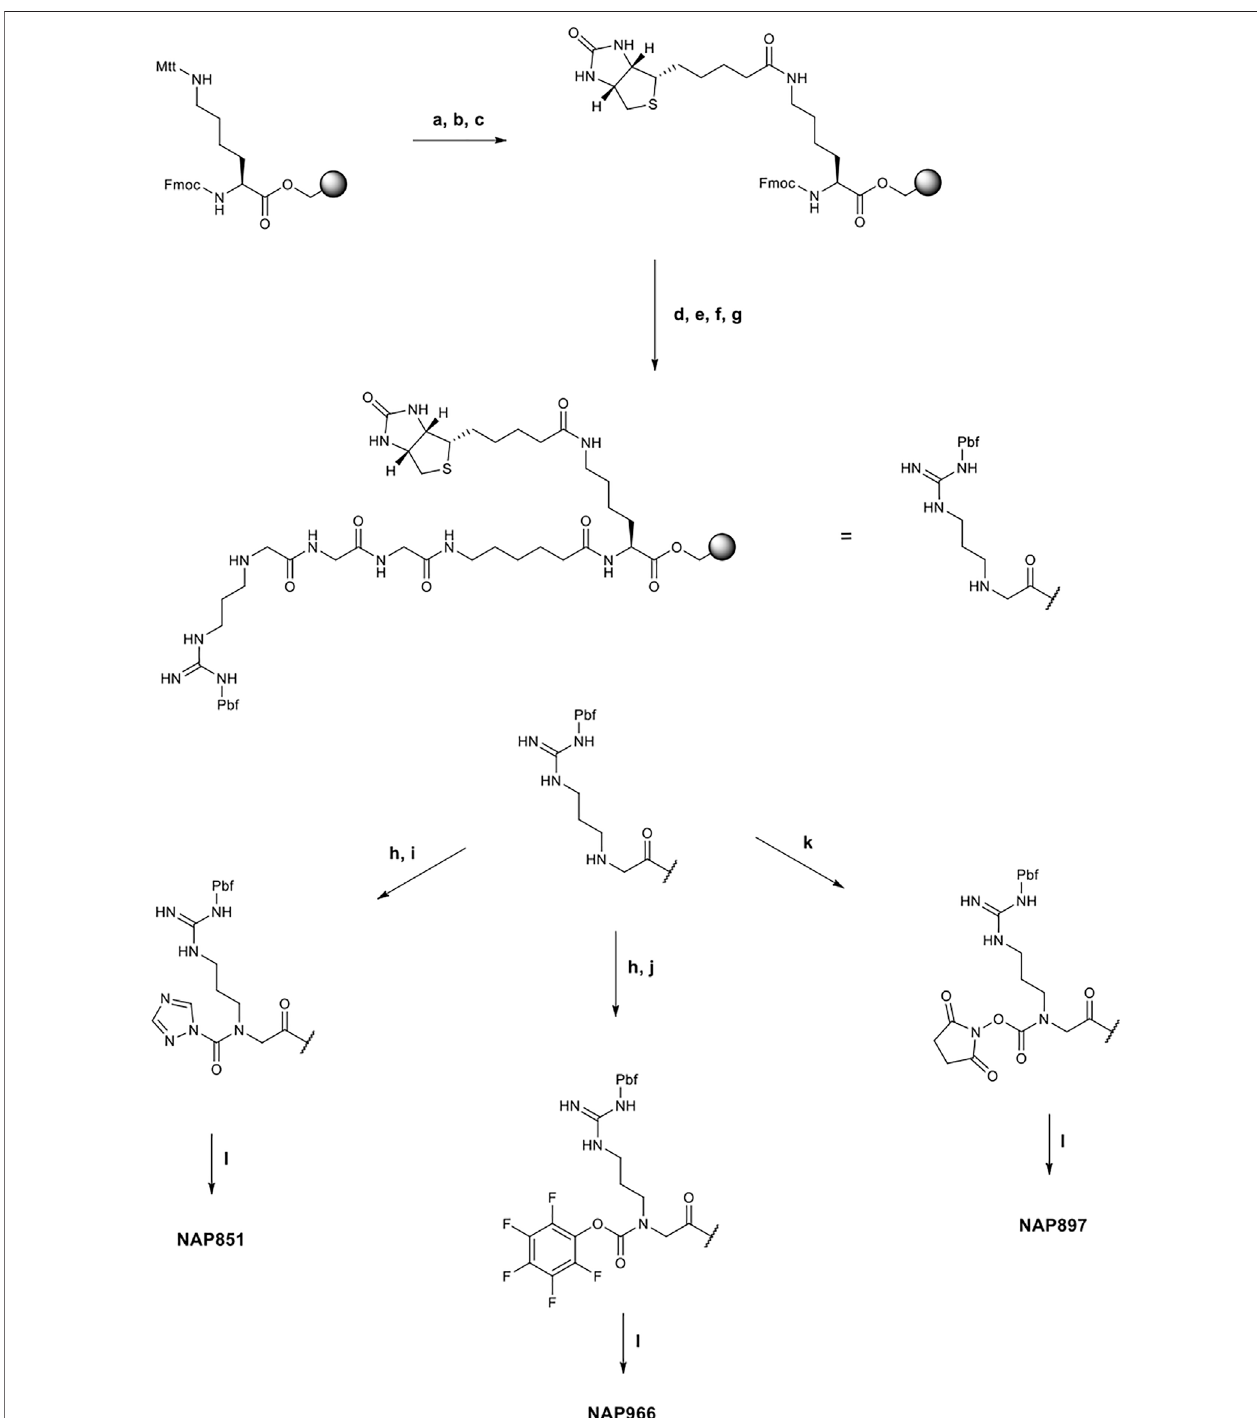
FIGURE 1 | Synthetic schemes for the preparation of NAP851, NAP966 and NAP897. (A) TFA/TIPS/DCM (5/5/90, v/v/v), (B) DIPEA/DMF (1/99 v/v), (C) Biotin, DIC, HOBt, NMP, (D) i) Piperidine/DMF (1/5, v/v), ii) Fmoc-Ahx-OH, DIC, HOBt, DMF, (E) i) Piperidine/DMF (1/5, v/v), ii) Fmoc-Gly-OH, DIC, HOBt, DMF, then repeat i) and ii) for a second Gly residue, (F) i) Piperidine/DMF (1/5, v/v), ii) Fmoc-NArg (Pbf)-OH, DIC, HOBt, DMF, (G) Piperidine/DMF (1/5, v/v), (H) Triphosgene, 2,6-lutidine, anhydrous DCM, (I) 1,2,4-triazole, 2,6-lutidine, DMAP, anhydrous DCM, (J) Penta fl uorophenol, 2,6-lutidine, DMAP, anhydrous DCM, (K) N,N ′ -disuccinimidyl carbonate, 2,6-lutidine, anhydrous DCM, (L) TFA/TIPS/DCM (95/2.5/2.5, v/v/v).